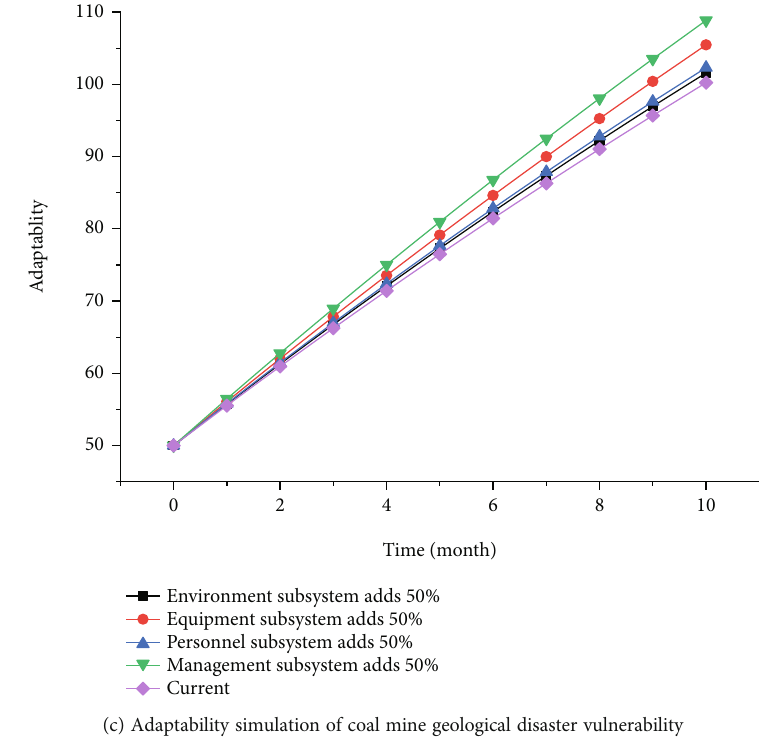
(c) Adaptability simulation of coal mine geological disaster vulnerability Figure 4: Simulation of coal mine geological disaster vulnerability.